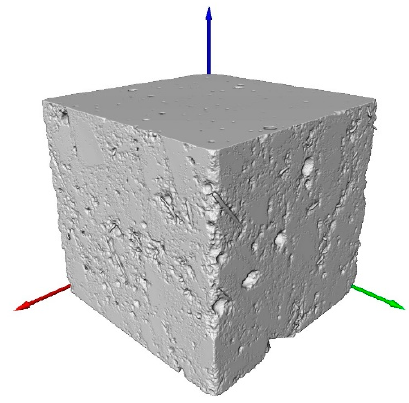
Figure 4. Example of 3D reconstruction.